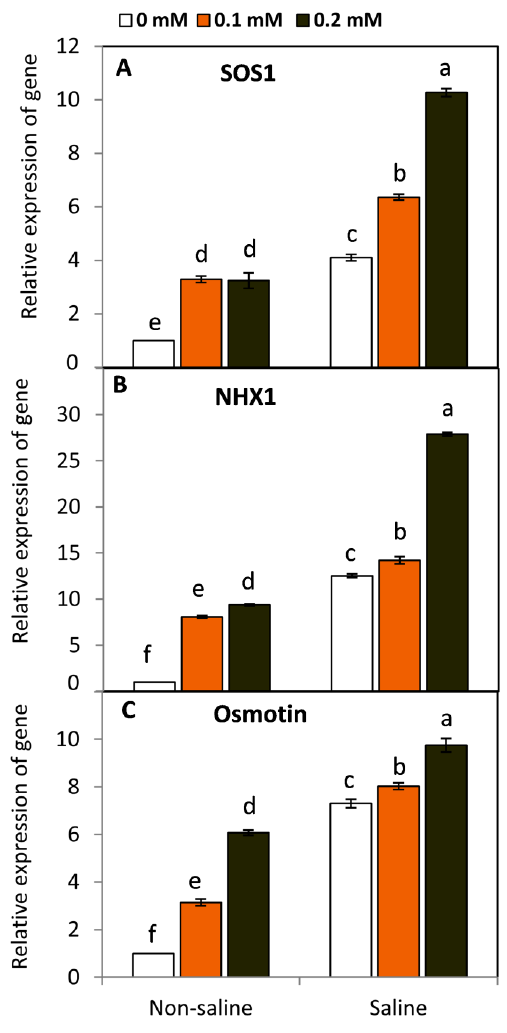
Figure 7. Effect of exogenous folic acid (FA; 0, 0.1, and 0.2 mM) on the relative expression of plasma membrane Na + /H + antiporter protein of salt overly sensitive gene ( SOS1 ) ( A ), vacuolar-localized Na + /H + antiporter protein ( NHX1 ) ( B ), and the multifunctional osmotic protective protein ( Osmotin ) ( C ) of snap bean plants grown under non-stressed and saline-stressed (50 mM, NaCl) conditions. Values are the averages of three replicates ± SD. Different letters indicate significant differences according to Duncan’s multiple range tests ( p <